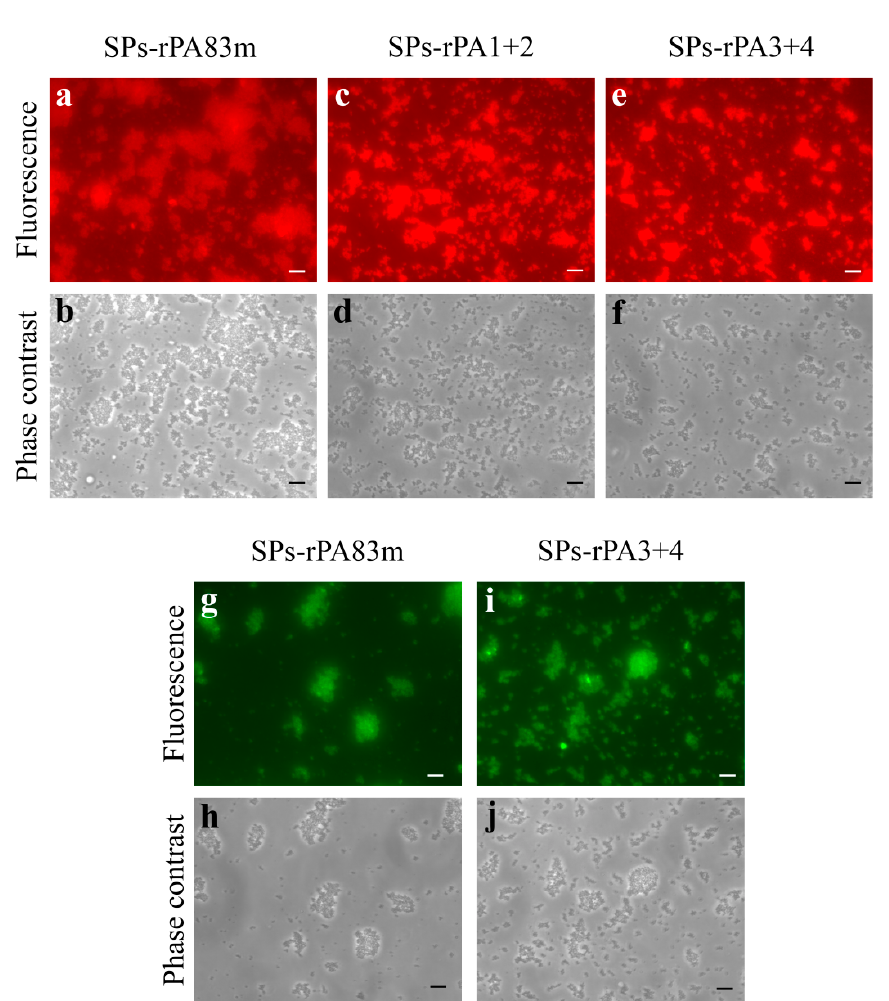
Figure 5. Compositions of SPs with anthrax modified recombinant antigens. Immunofluorescence analysis of SPs-rPA83m ( a , b , g , h ), SPs-rPA1+2 ( c , d ) and SPs-rPA3+4 ( e , f , i , j ) compositions. ( a , b ), ( c , d ), ( e , f ), ( g , h ), ( i , j ) in pairs are the same images presented in fluorescence and phase contrast modes, respectively. The SPs-protein compositions were treated with polyclonal antiserum to rPA83m ( a , b ), to rPA1+2 ( c , d ) or to rPA3+4 ( e , f ) or with chimeric monoclonal PA-neutralising antibodies ( g – j ) and secondary antibodies conjugated to Alexa Fluor ® 546 ( a – f ) or to CF™ 488A ( g – j ). Scale bars, 5 µ m. SPs/antigen mass ratio within compositions is 10/1. Compositions were obtained in 1 × PBS. Images of corresponding negative control samples (not incubated with primary antibodies) are presented in the Figure S3a–j, respectively. Images of SPs-rPA1+2 compositions treated with chimeric monoclonal PA-neutralising antibodies and secondary antibodies conjugated to CF™ 488A as a negative control represented in Figure S3k,l (k—fluorescence analysis, l—phase